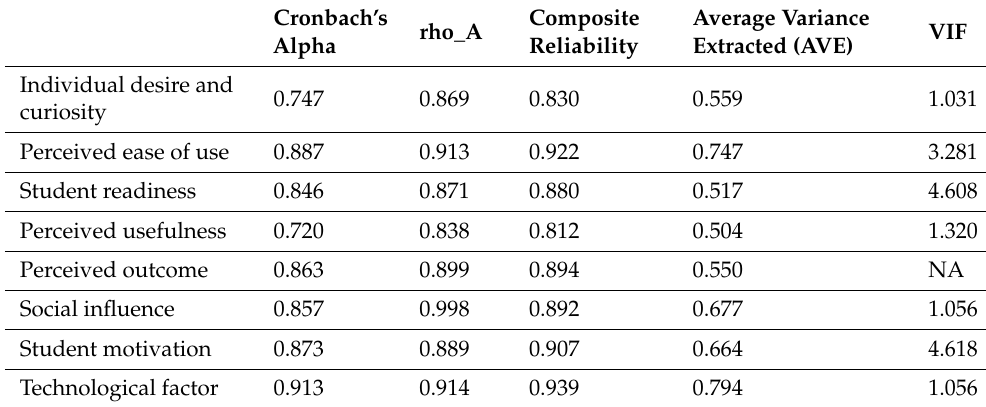
Table 6. Construct reliability and validity.